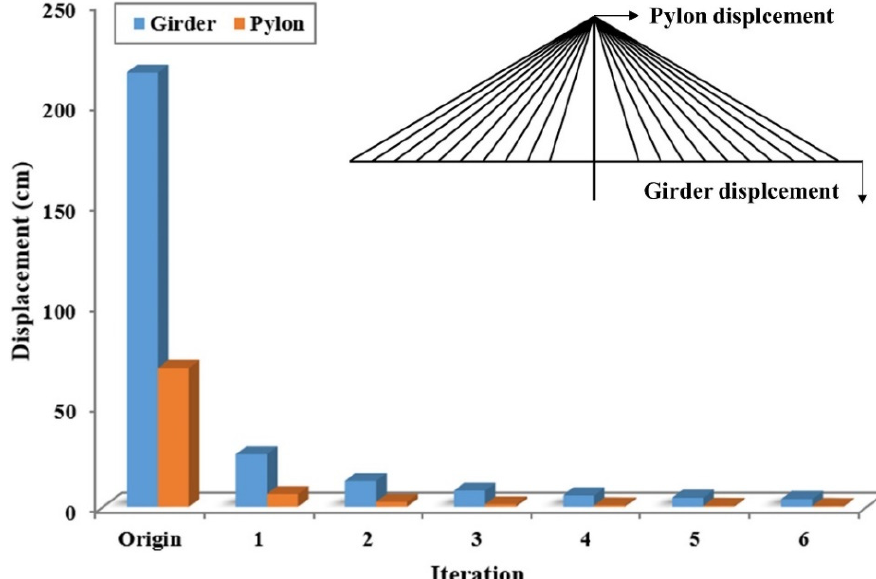
Figure 3. Pylon and girder displacement in each stage of initial shape analysis.